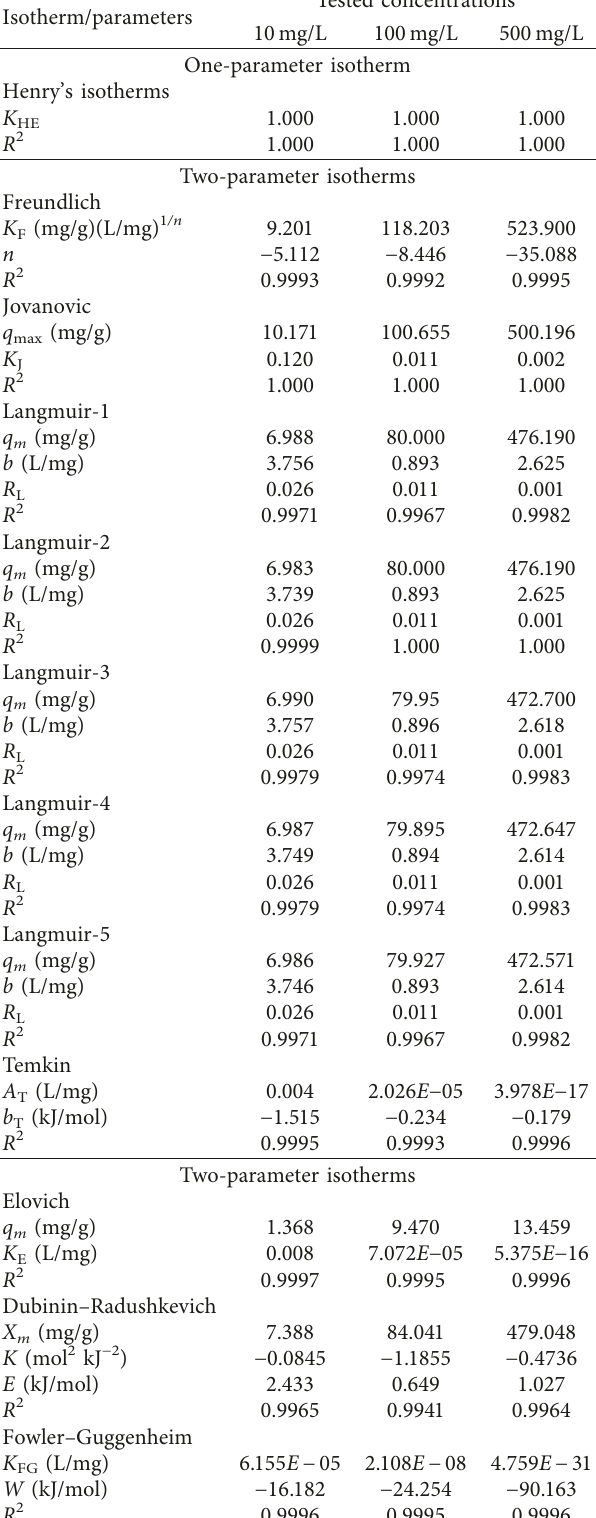
Table 5: Thermodynamic parameters at 100mg/L initial Co(II) concentration.